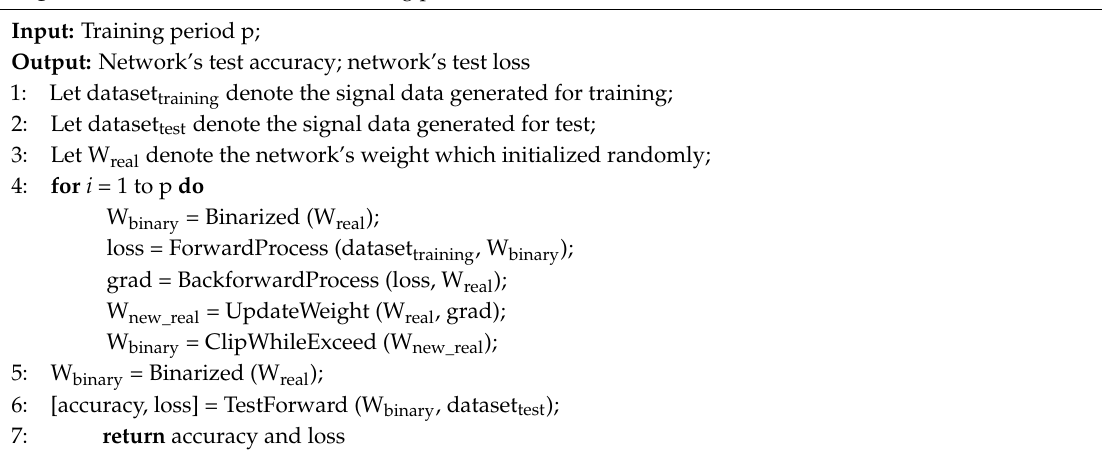
Algorithm 1. Pseudocode of the training